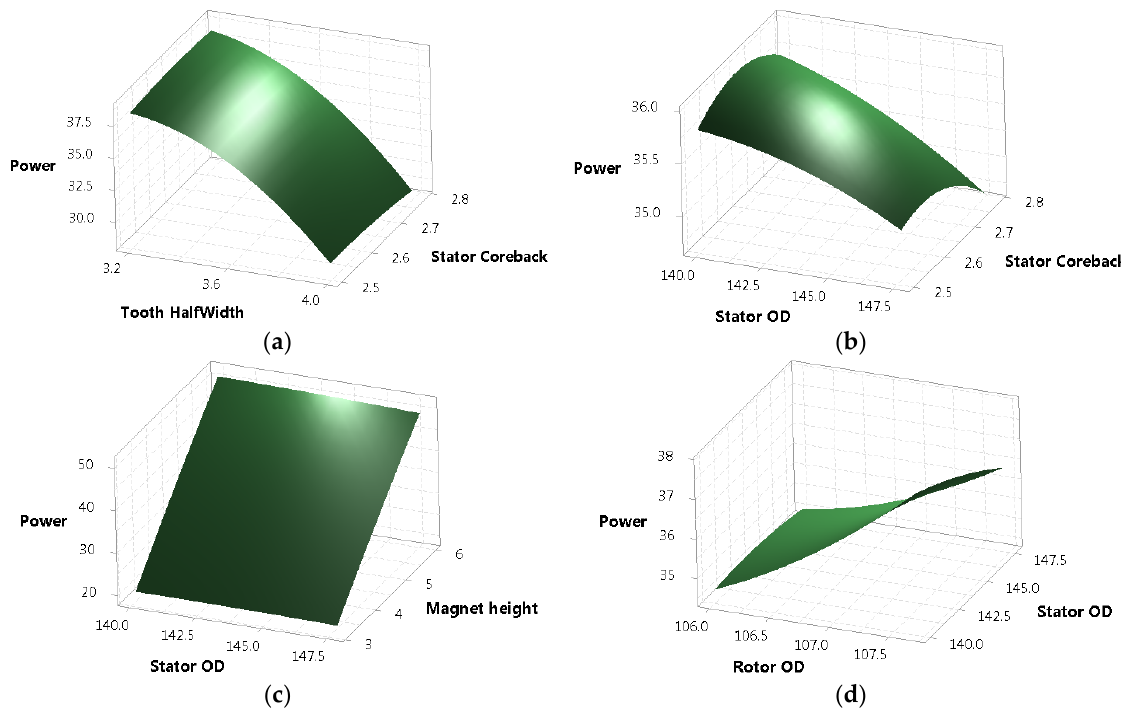
Figure 3. Response surface plots: effect of geometrical design variables in mm on the TFM output power, ( a ) Tooth width (half), stator core back thickness vs. power; ( b ) stator outer diameter (OD), stator core back vs. power; ( c ) stator OD, magnet height vs. power; ( d ) rotor OD, stator OD vs. power.